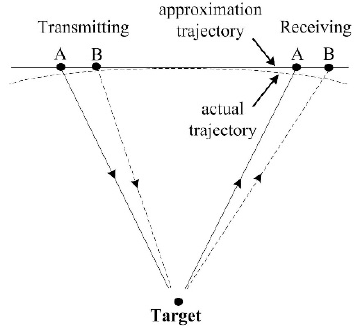
Figure 3. The continuous rectilinear model.